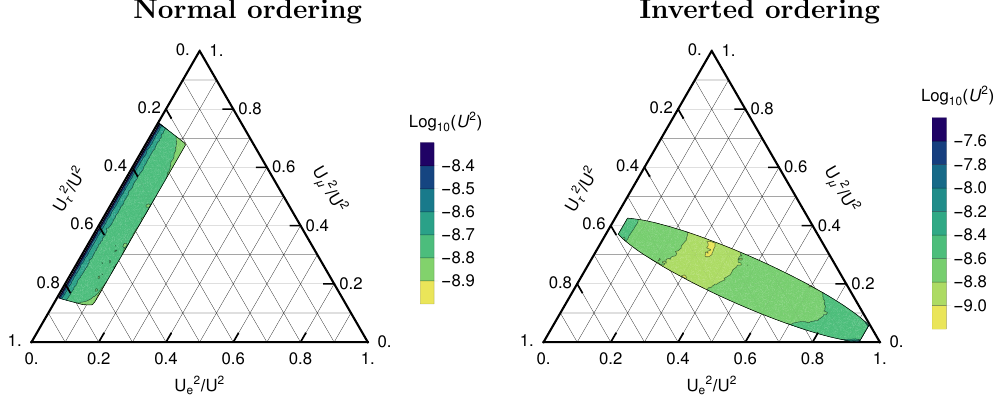
Figure 9 . The region within the black lines is allowed by light neutrino oscillation data. The colour indicates the largest mixing angle U 2 consistent with the observed BAU and seesaw constraints for the cases of normal ordering (left) and inverted ordering (right) for right-handed neutrino with an average mass (cid:22) M = 30 GeV. Note that the largest viable mixing angles are found in the case of